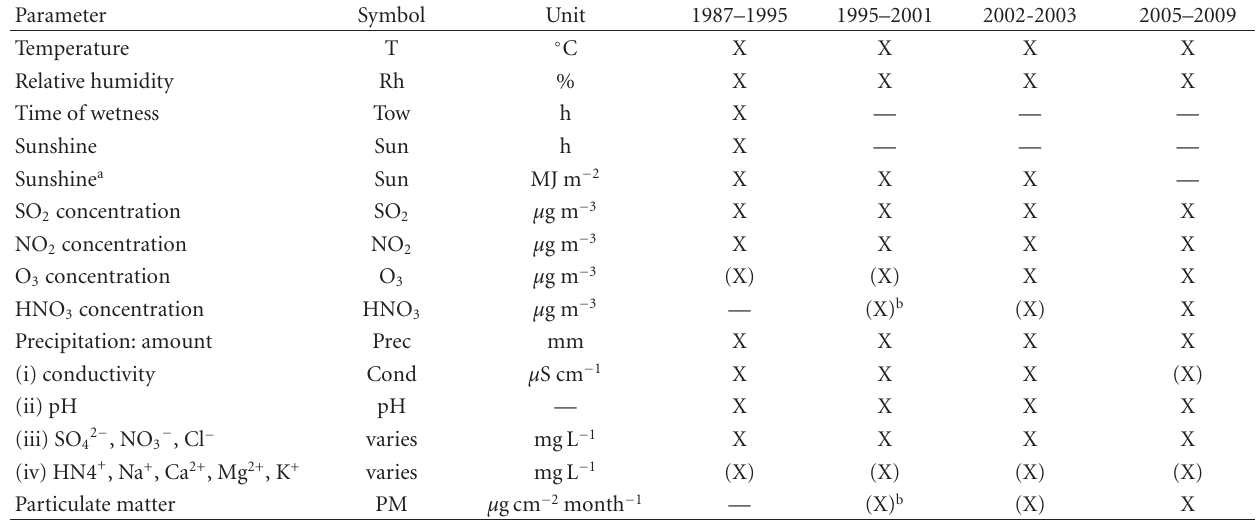
Table 2: Reported environmental data from ICP Materials test 1987–2009: X: mandatory; (X): optional; —: not reported. Parameter